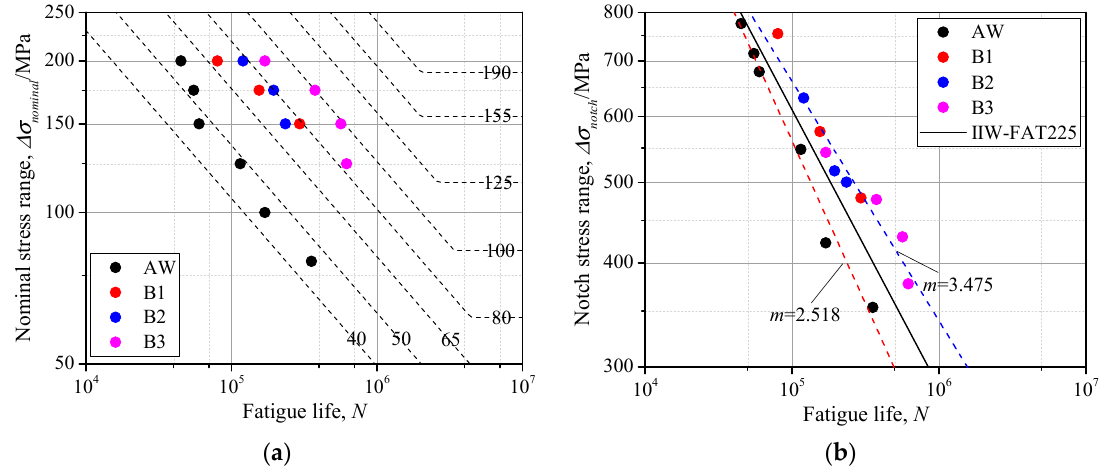
Figure 12. The S-N curves: ( a ) nominal stress; ( b ) notch stress. As seen in Figure 12a, the data of as-welded gussets are scattered around the Class 50, which is the recommended fatigue strength for the gusset welded joints by JSSC. The fatigue life of gusset welded joints obviously improved after additional welding, and the fatigue strength increased by two or three classes. This was because the increasing weld toe radius r 1 and bottom weld leg length L 1 contributed to the smaller SCF. For the addi- tional weld with different distance from the weld toe, the B3 series, which had the greatest distance, illustrated much greater fatigue life because of the greater weld toe radius r 1 and